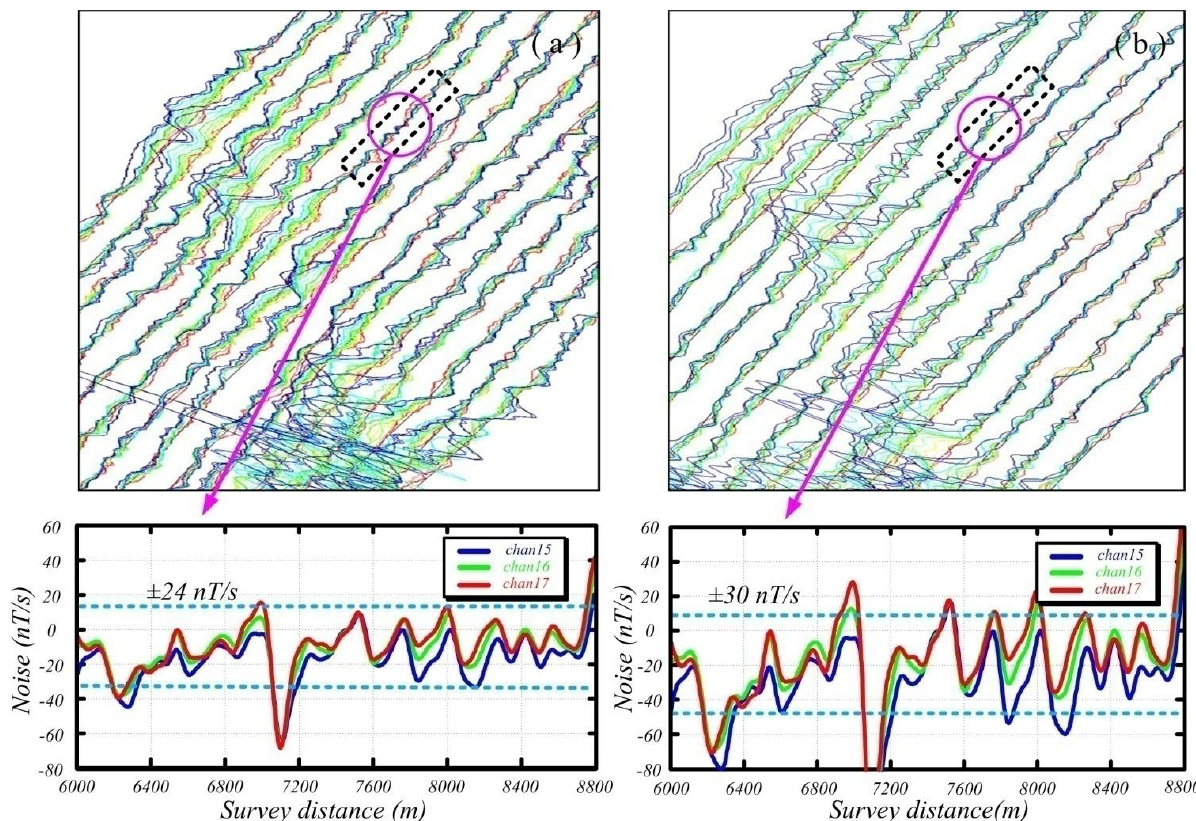
Figure 13. Cross-section maps of different survey lines detected by the ( a ) ACS-based helicopter TEM system and ( b ) the AeroTEM